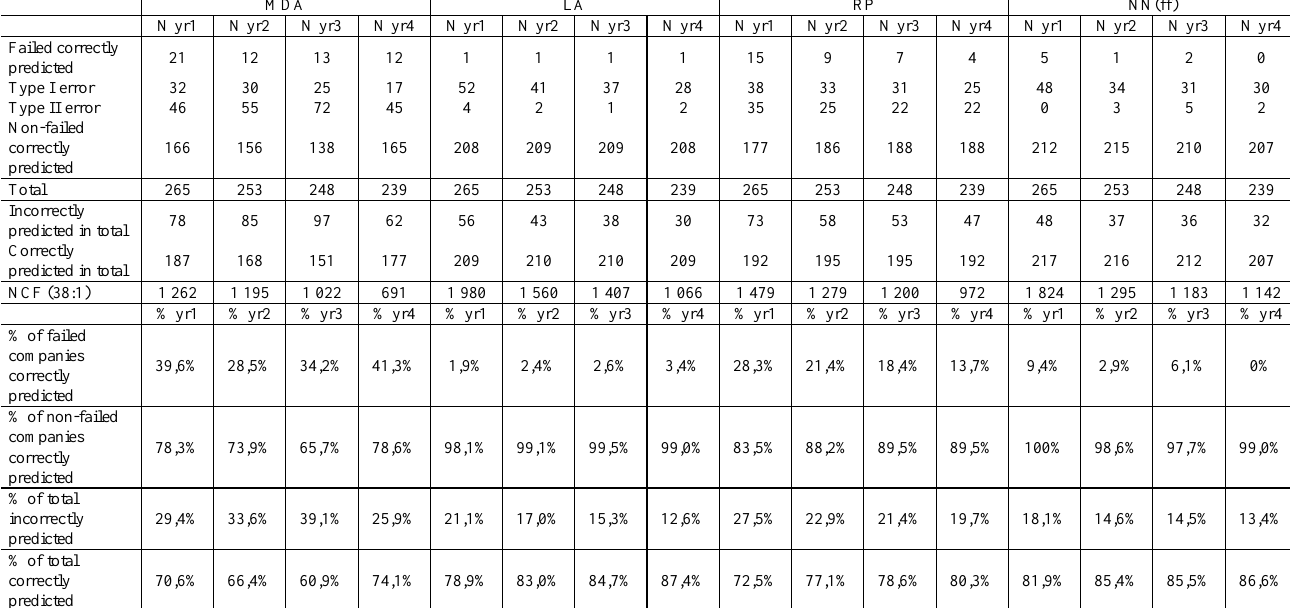
Table 2: Results of the models developed by means of different